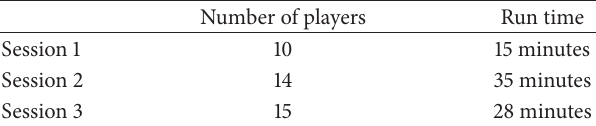
Table 2: Session parameters for algorithm